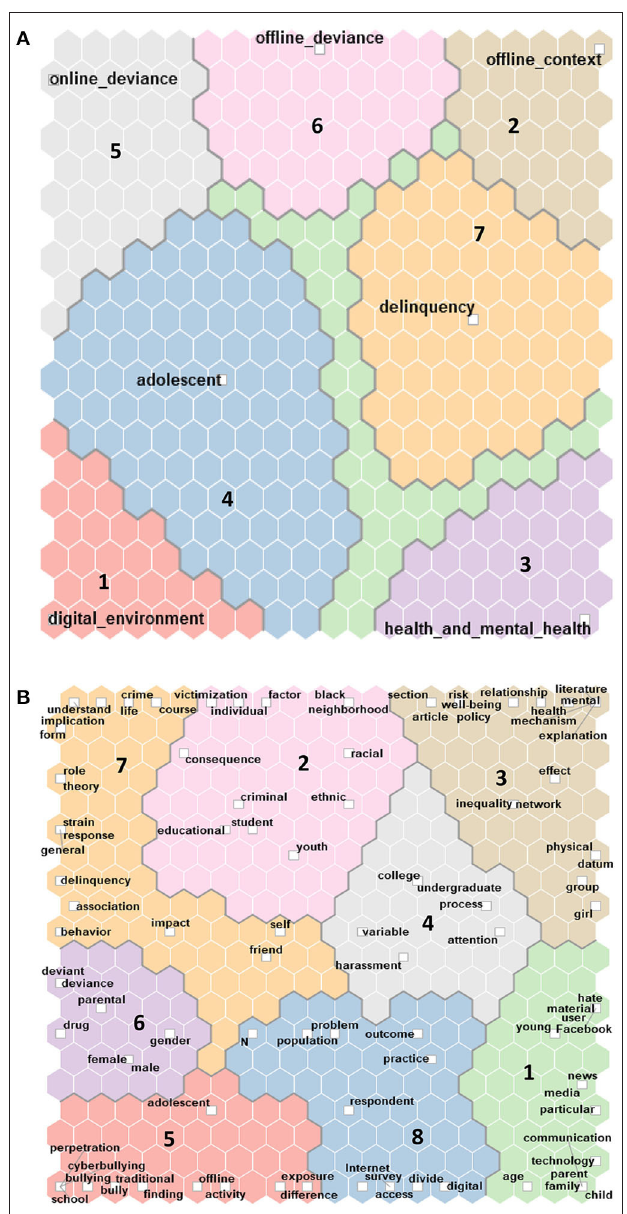
FIGURE 3 | (A) Self-organizing map data set 1. (B) Self-organizing map data set 1.